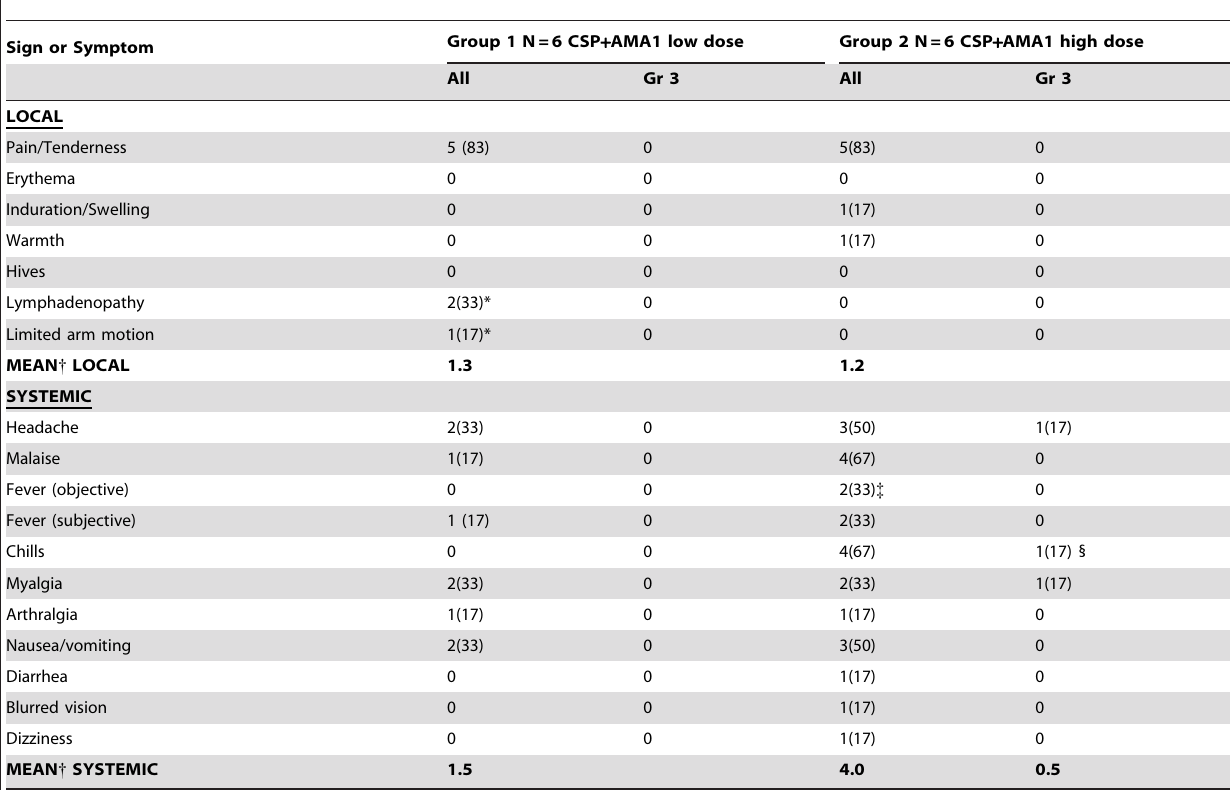
Table 5. Local and systemic Adverse Events in Group 1 and Group